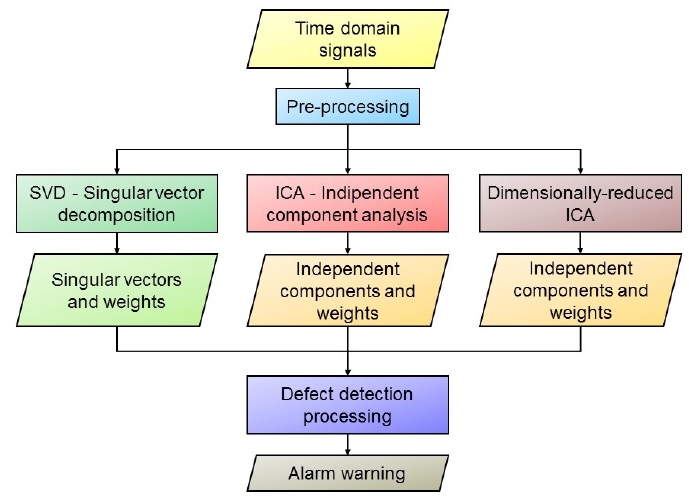
Figure 18. Processing steps in defect